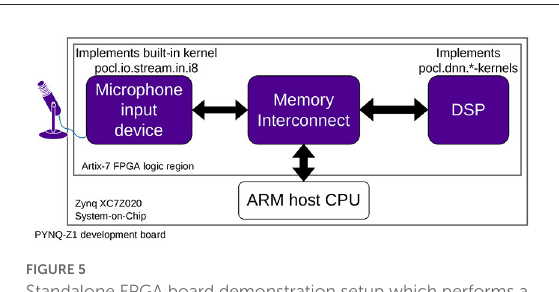
FIGURE5 Standalone FPGA board demonstration setup which performs a real-time classification of an audio